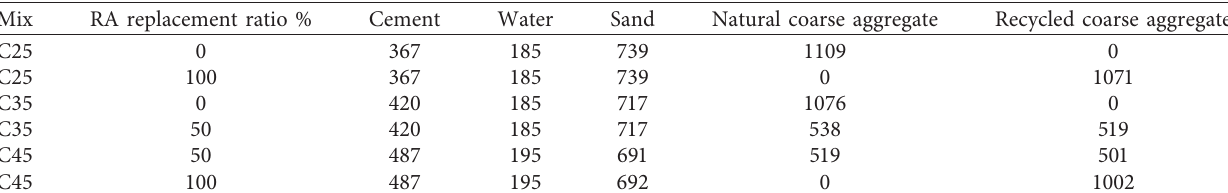
Table 6: Details of the mixes proportions (kg/m 3